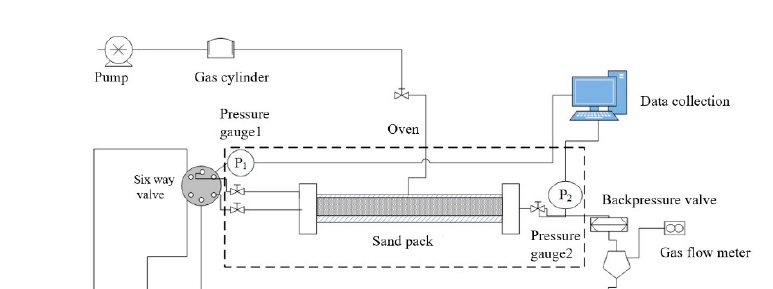
Figure 4. The flowchart of the physical model displacement device.